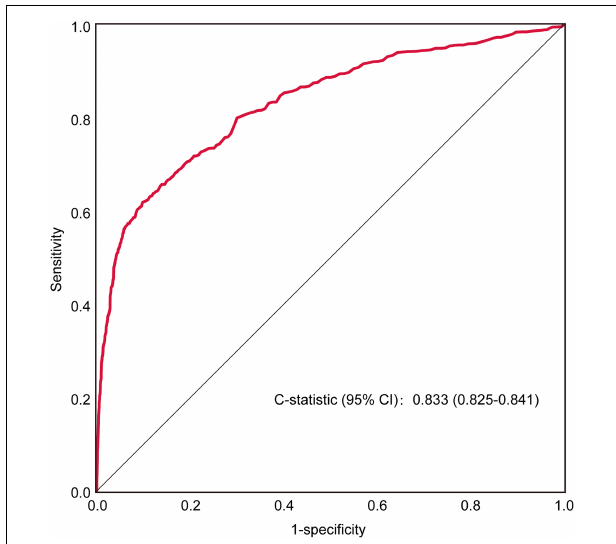
FIGURE 3 | ROC curve for the model in the external validation cohort.